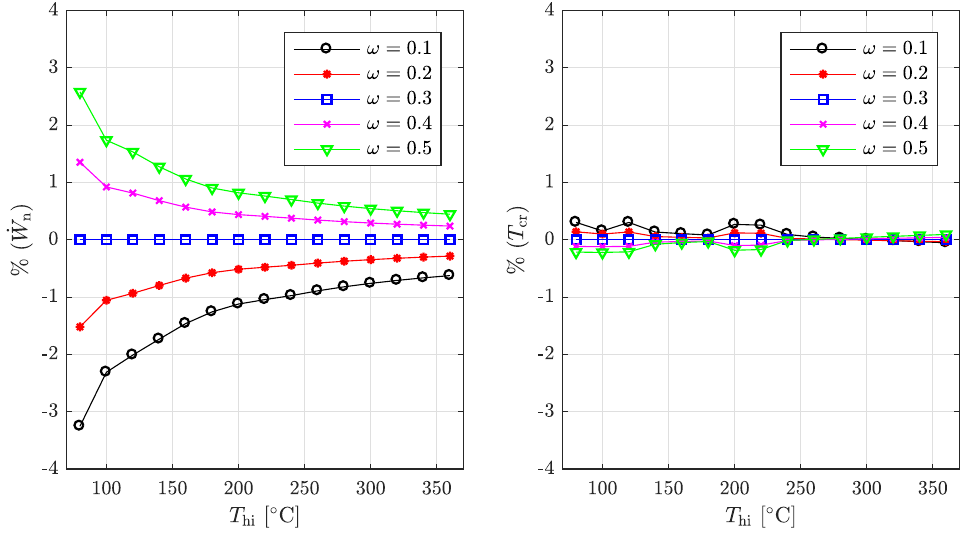
Figure 8. Sensitivity analysis on the effect of ω on ˙ W n ( left ) and T cr ( right ) for an unconstrained ( p 1 ≥ 5 kPa) subcritical ORC system for different heat-source temperatures. Results are compared to optimal systems for ω =